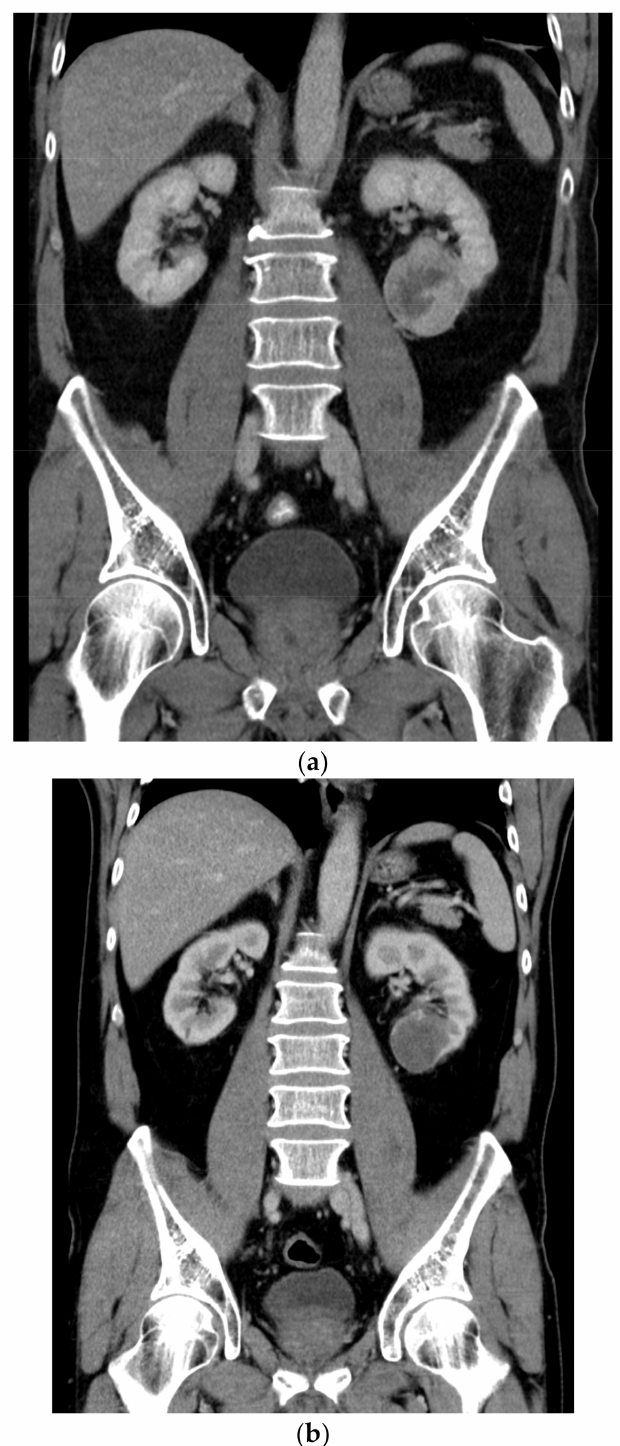
Figure 1. ( a ) Initial contrast-enhanced CT scan in a coronal plane. A tumor on the lower pole of the left kidney contains a heterogeneous enhancing soft-tissue component and a central necrosis. ( b ) Follow-up contrast-enhanced CT scan in a coronal plane. There is only slight regression of the tumor size, but the soft-tissue component is replaced by hemorrhagic fluid and a thin fibrous